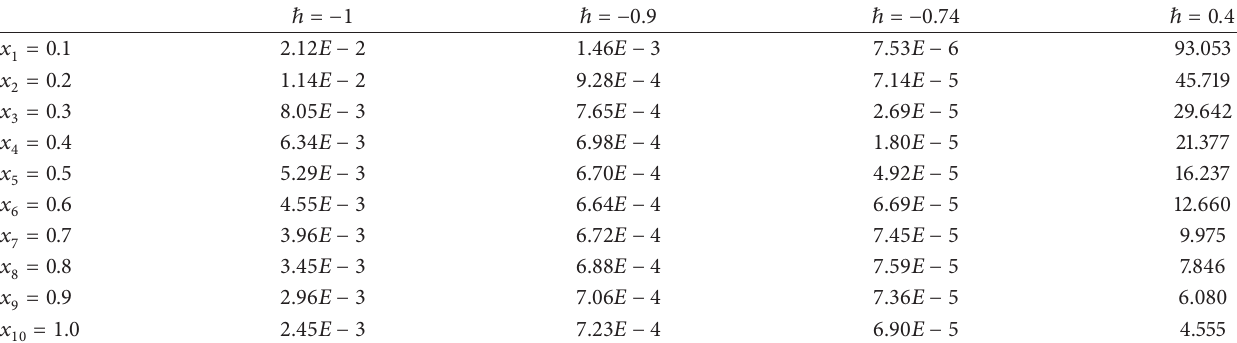
Table 2: Comparison of relative errors 𝛿(𝑥 𝑗 ) for Example